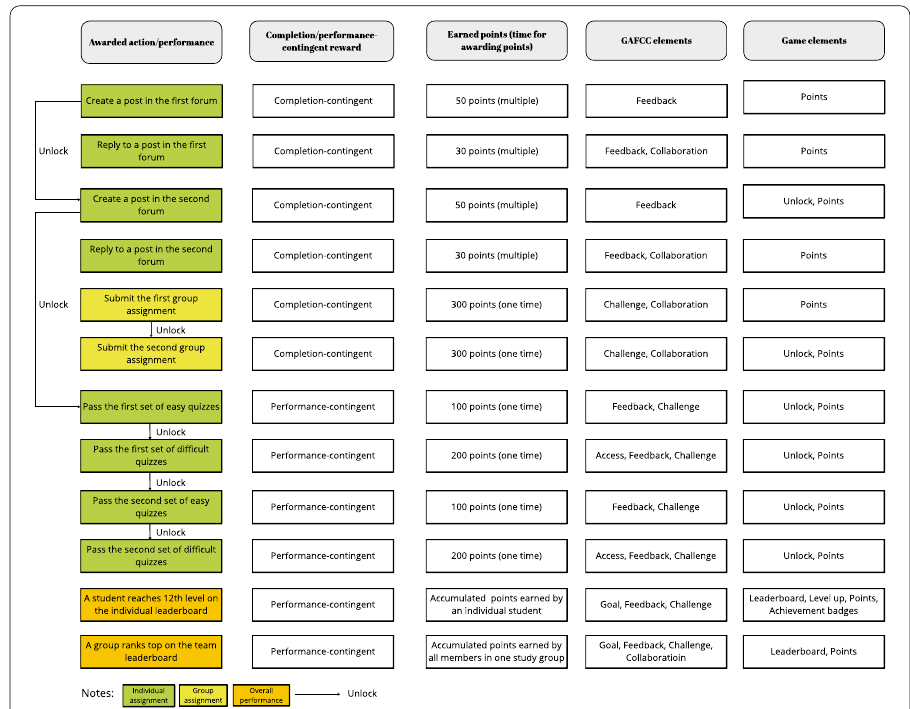
Fig. 1 Points-adding system used in the GAFCC group (Study